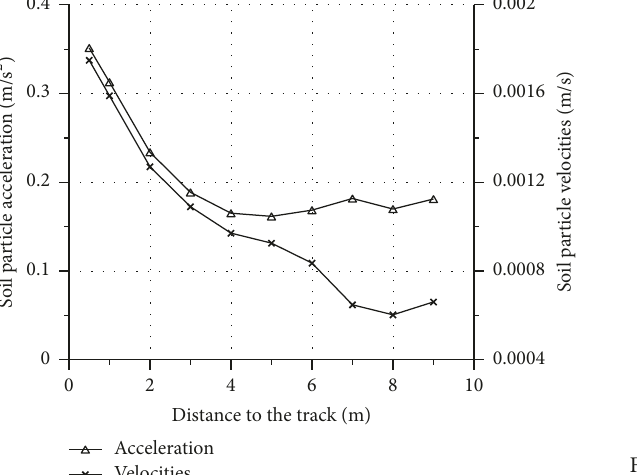
Figure 10: Vertical (solid line) and horizontal (dashed) maximum vibration velocities and acceleration in different floors of the building.